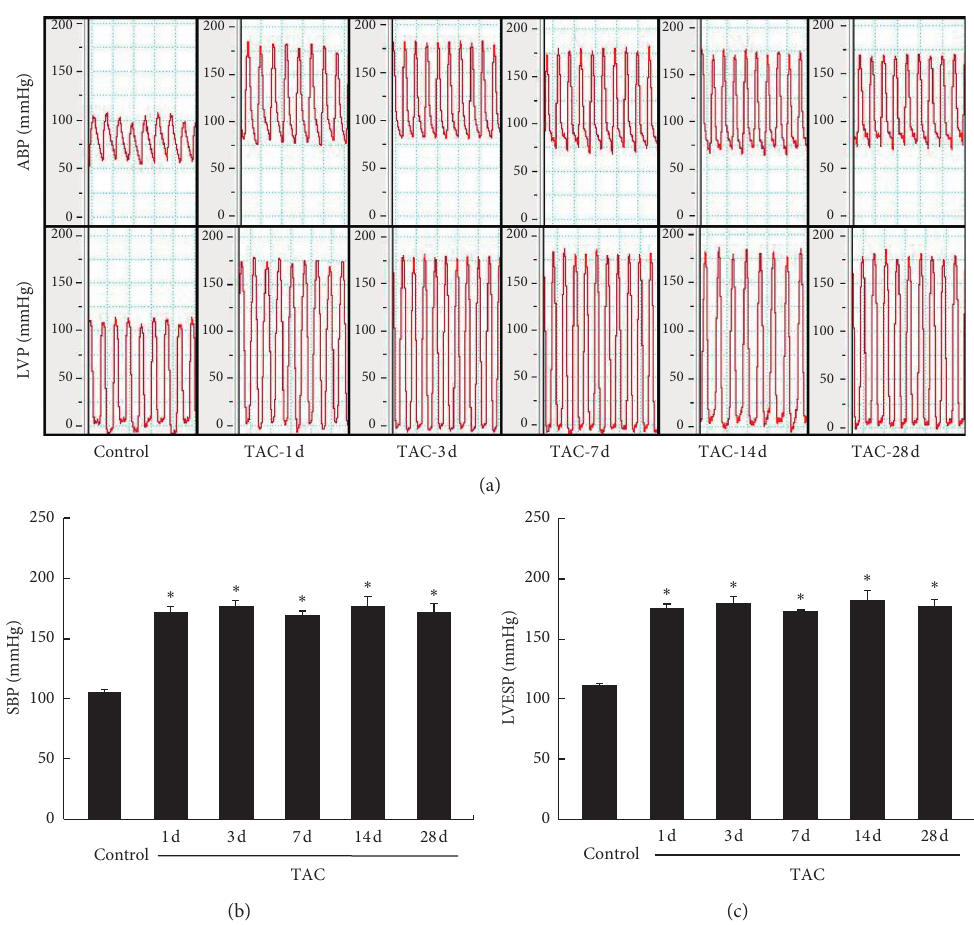
Figure 1: Haemodynamic assessment in mice within 4 weeks after transverse aortic constriction (TAC). ABP: aortic blood pressure; LVP: LV pressure; SBP: systolic blood pressure; LVESP: left ventricular end-systolic pressure. Values are expressed as mean ± S.E.M. n > 8 per group in each group. ∗ P < 0 . 01 versus control.